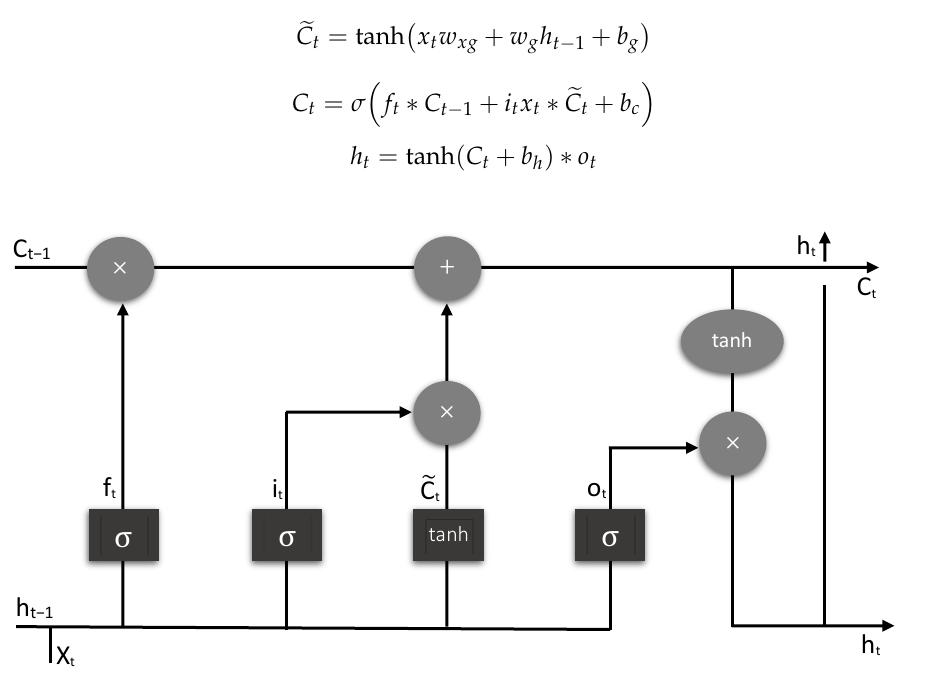
Figure 3. Basic architecture of